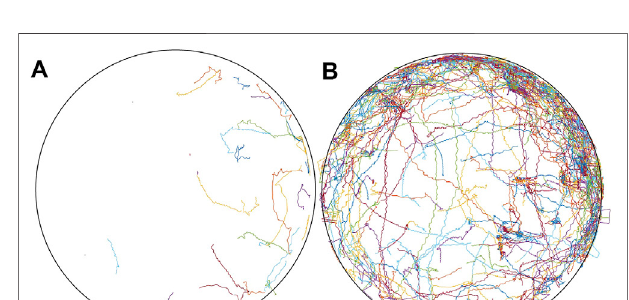
the means were plotted along with the standard error of the mean Figure 2C . A standard t -test was applied between groups (ttest2 function in MATLAB) and p -values < 0.05 were considered signi fi cant. The mean tangential velocities and circulating